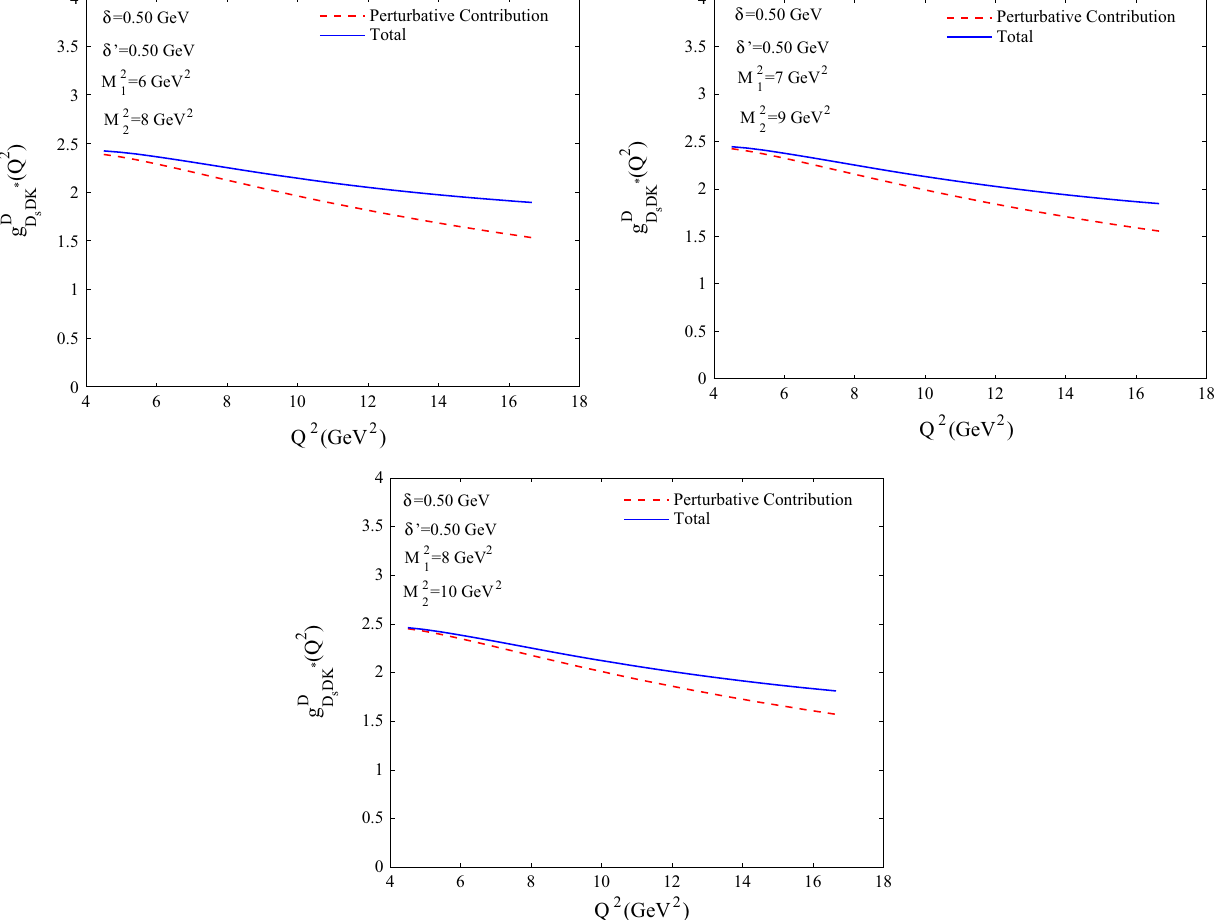
on Q 2 for different values of the Borel D s DK ∗